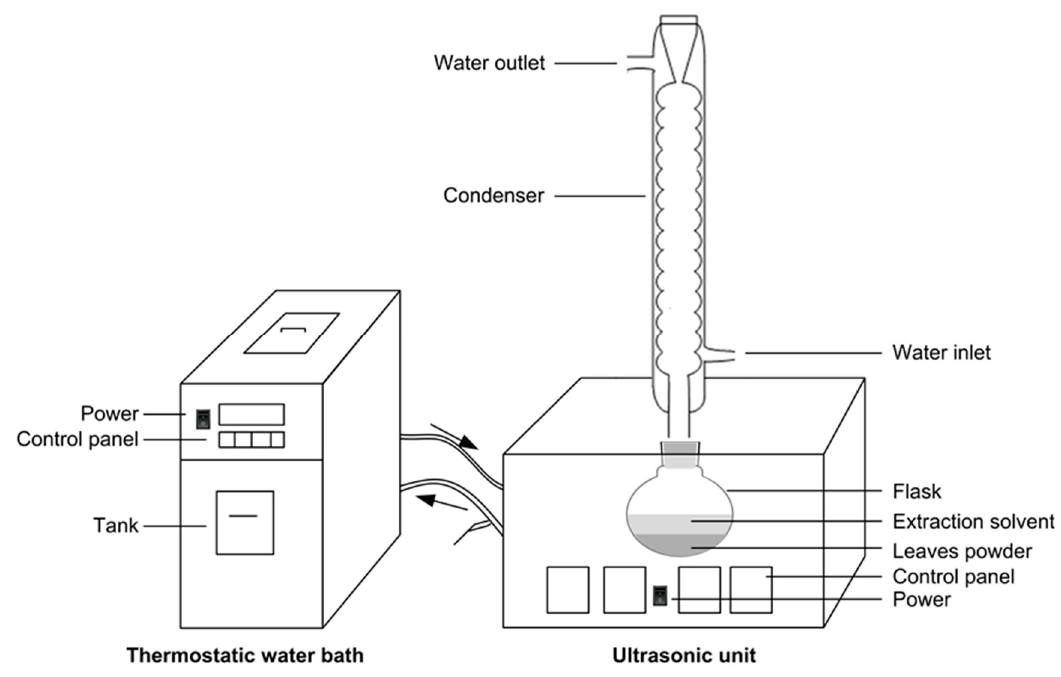
Figure 2. The schematic representation of the ultrasonic heat–reflux extraction device.